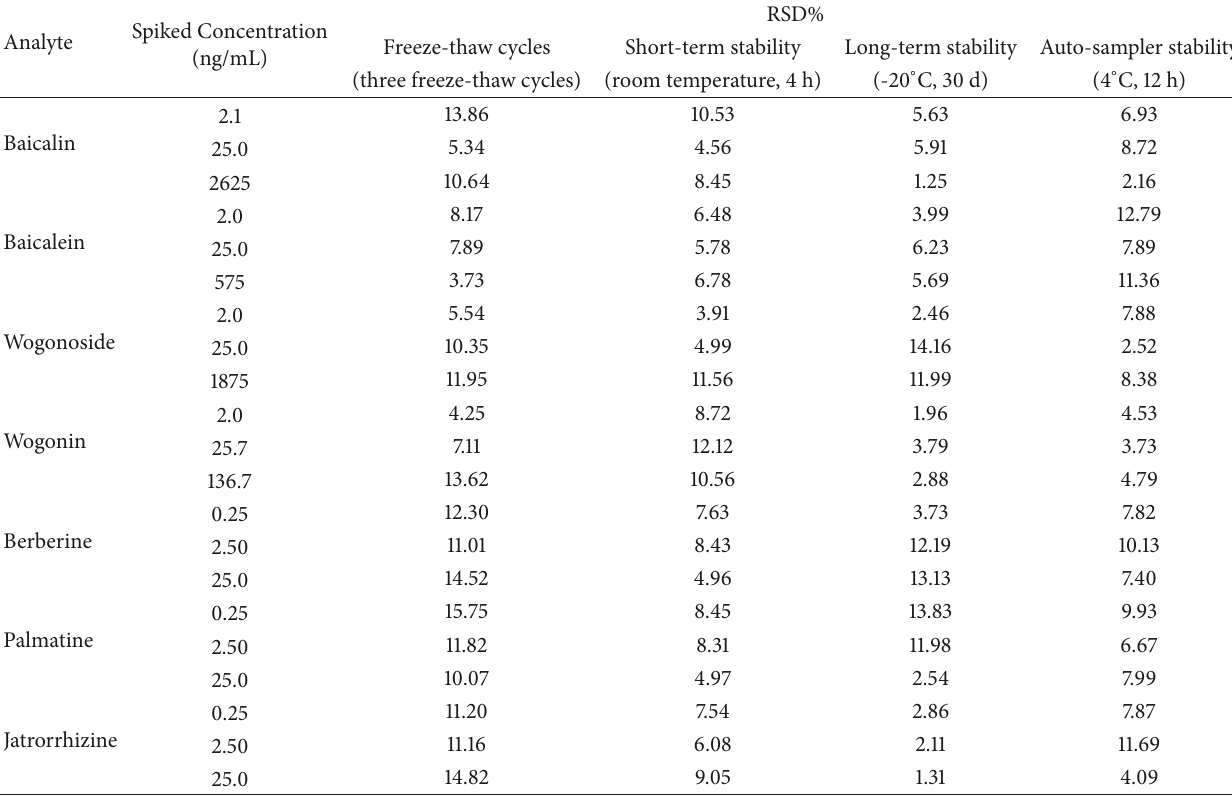
Table 5: Stability of the components in rat plasma under a variety of storage and process conditions. Analyte